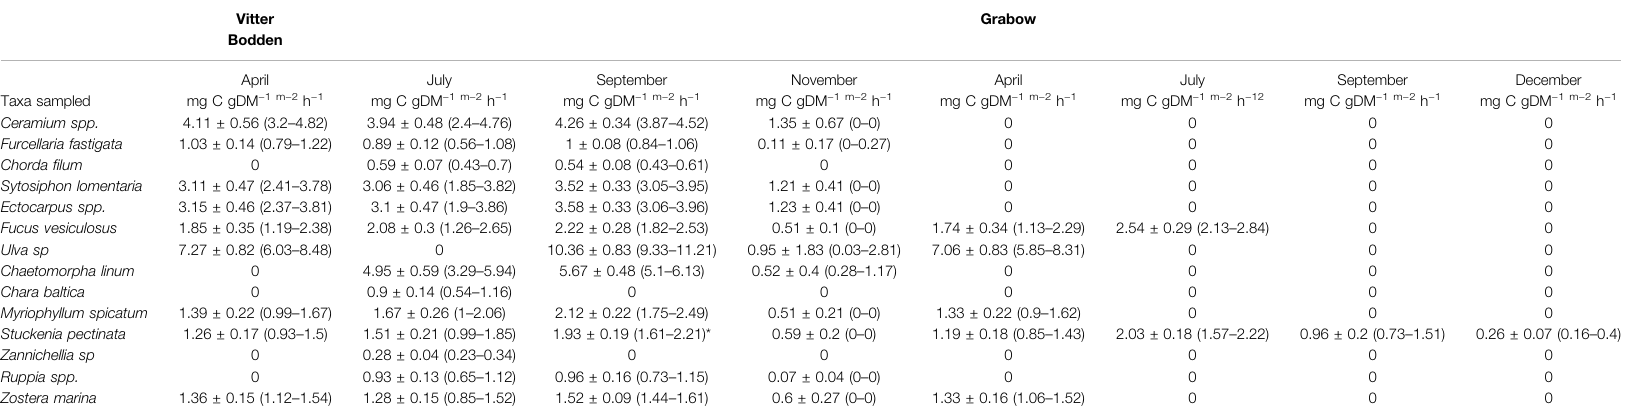
(PAR mc ) and species-speci fi c photosynthetic parameters taken from the literature ( Table 2 ). In winter, for some species bootstrap con fi dence intervals could not be calculated due to reduced sample size. An asterisk indicates a signi fi cant difference between the lagoons within one